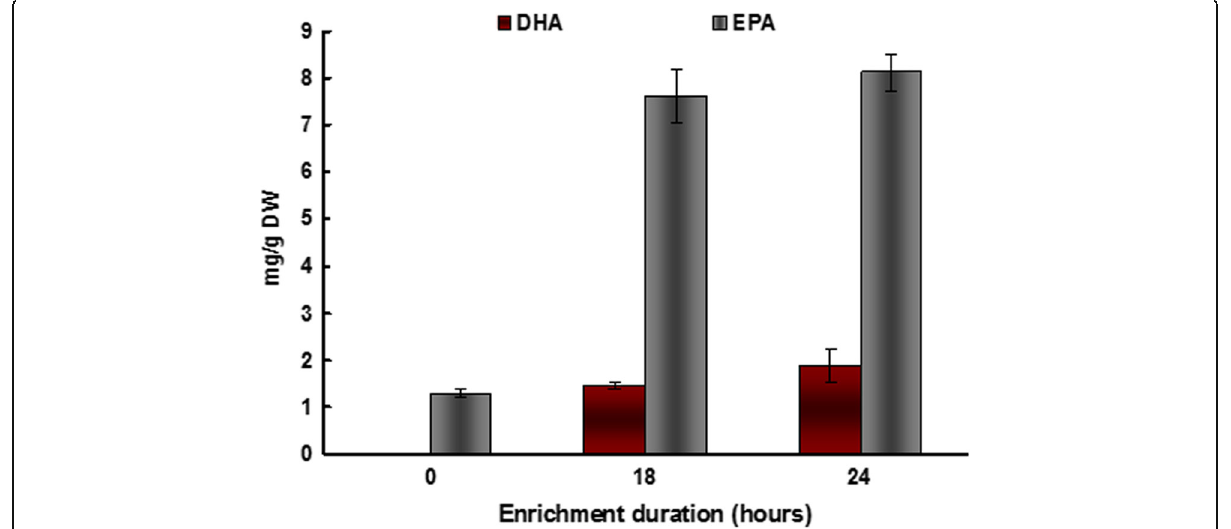
Fig. 4 EPA and DHA levels in Artemia nauplii under different enrichment